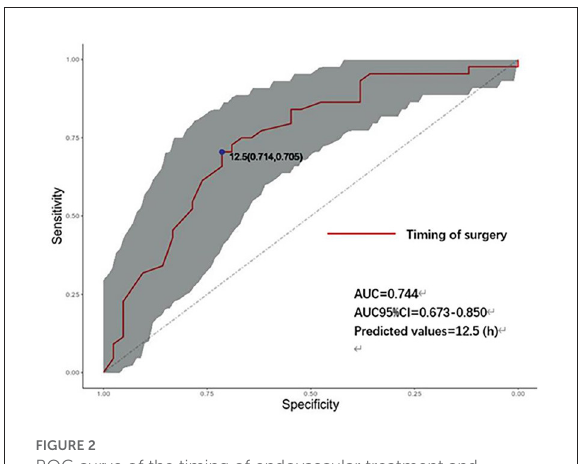
FIGURE2 ROC curve of the timing of endovascular treatment and prognosis. AUC, area under the curve; CI, confidence interval (Shaded parts). h: hours, timing of aneurysm